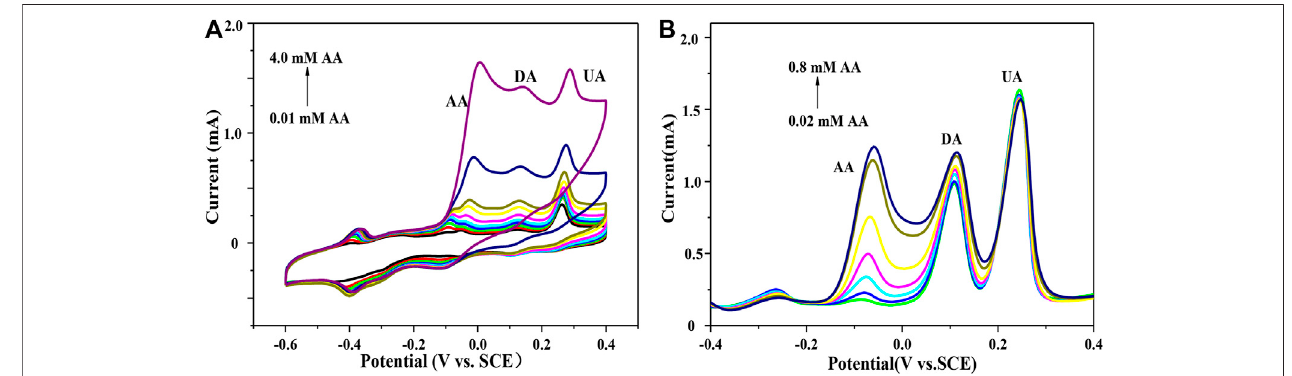
FIGURE 4 | 7 h GNSs/CC electrode detects AA in the presence of DA and UA. (A) CV. (B) DPV.